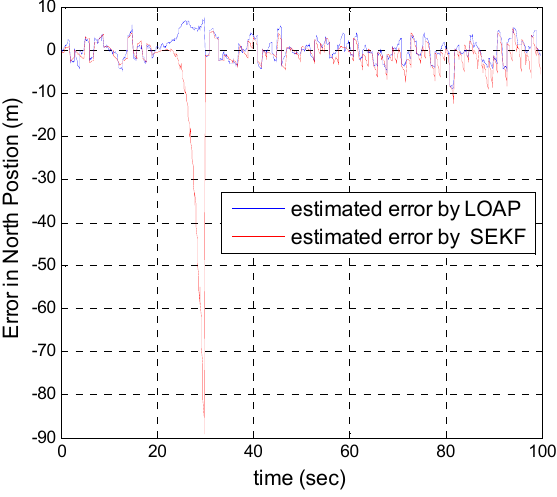
Figure 11. Error estimation of north position.